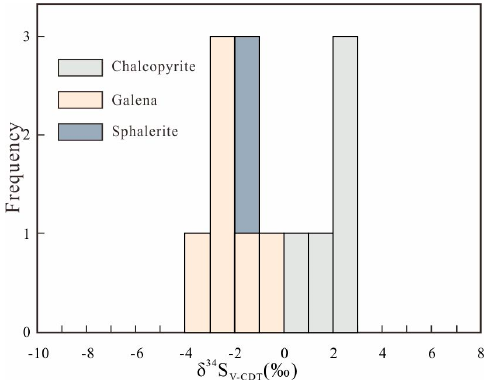
Figure 12. The Sulfur isotope histogram of the Chuduoqu Pb-Zn-Cu deposit. δ 34 S values of mantle, sedimentary rock, metamorphic rock and meteorite are quoted from [53].